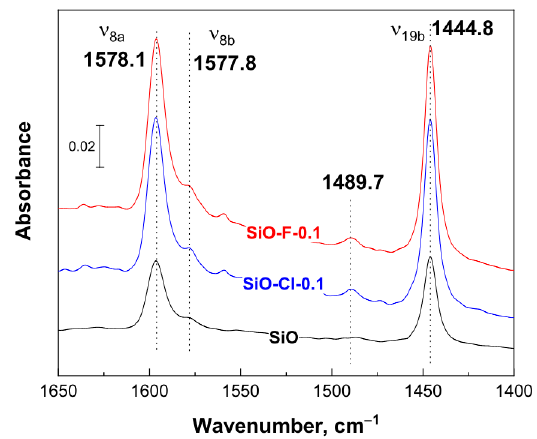
Figure 4. FTIR spectra of pyridine adsorbed on the modified and unmodified SiO 2 after evacuation at 50 °C.